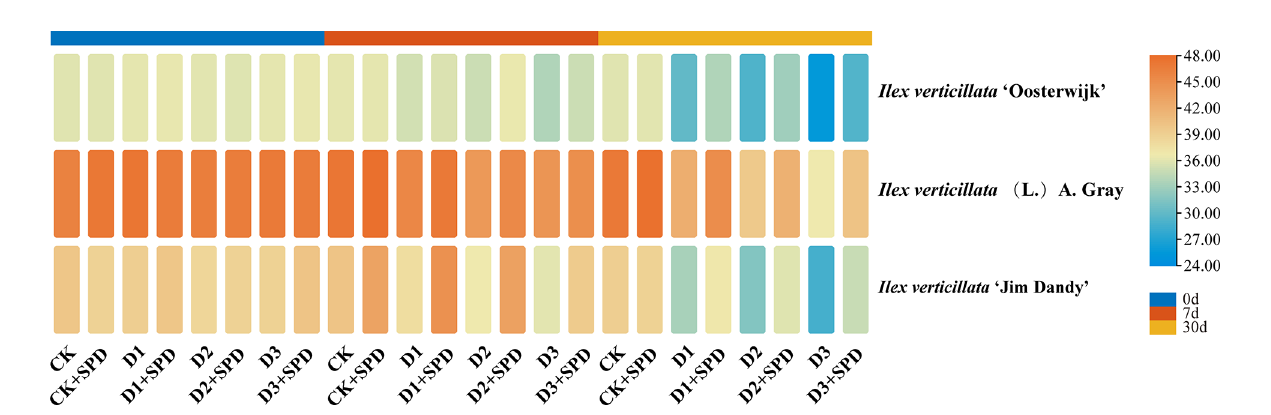
FIGURE 2 The changes of speci fi c leaf weight in Ilex verticillata leaves under drought and spermidine treatment. Data were shown in a heatmap, where orange indicates high values and blue indicates low values. CK, control; CK+SPD, control with spermidine; D1, mild drought; D1+SPD, mild drought with spermidine; D2, moderate drought; D2+SPD, moderate drought with spermidine; D3, severe drought; D3+SPD, severe drought with